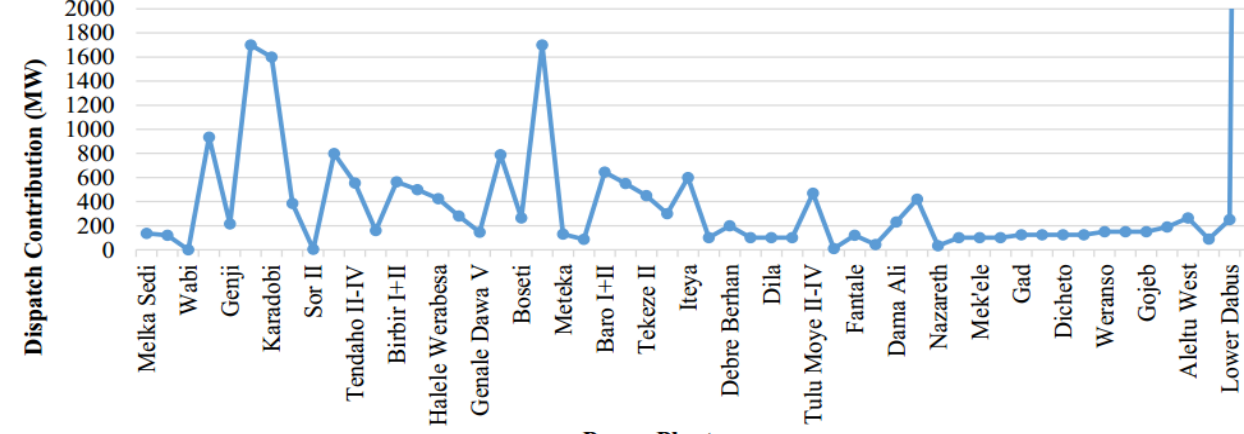
Figure 10. Generation dispatch share of Ethiopian power